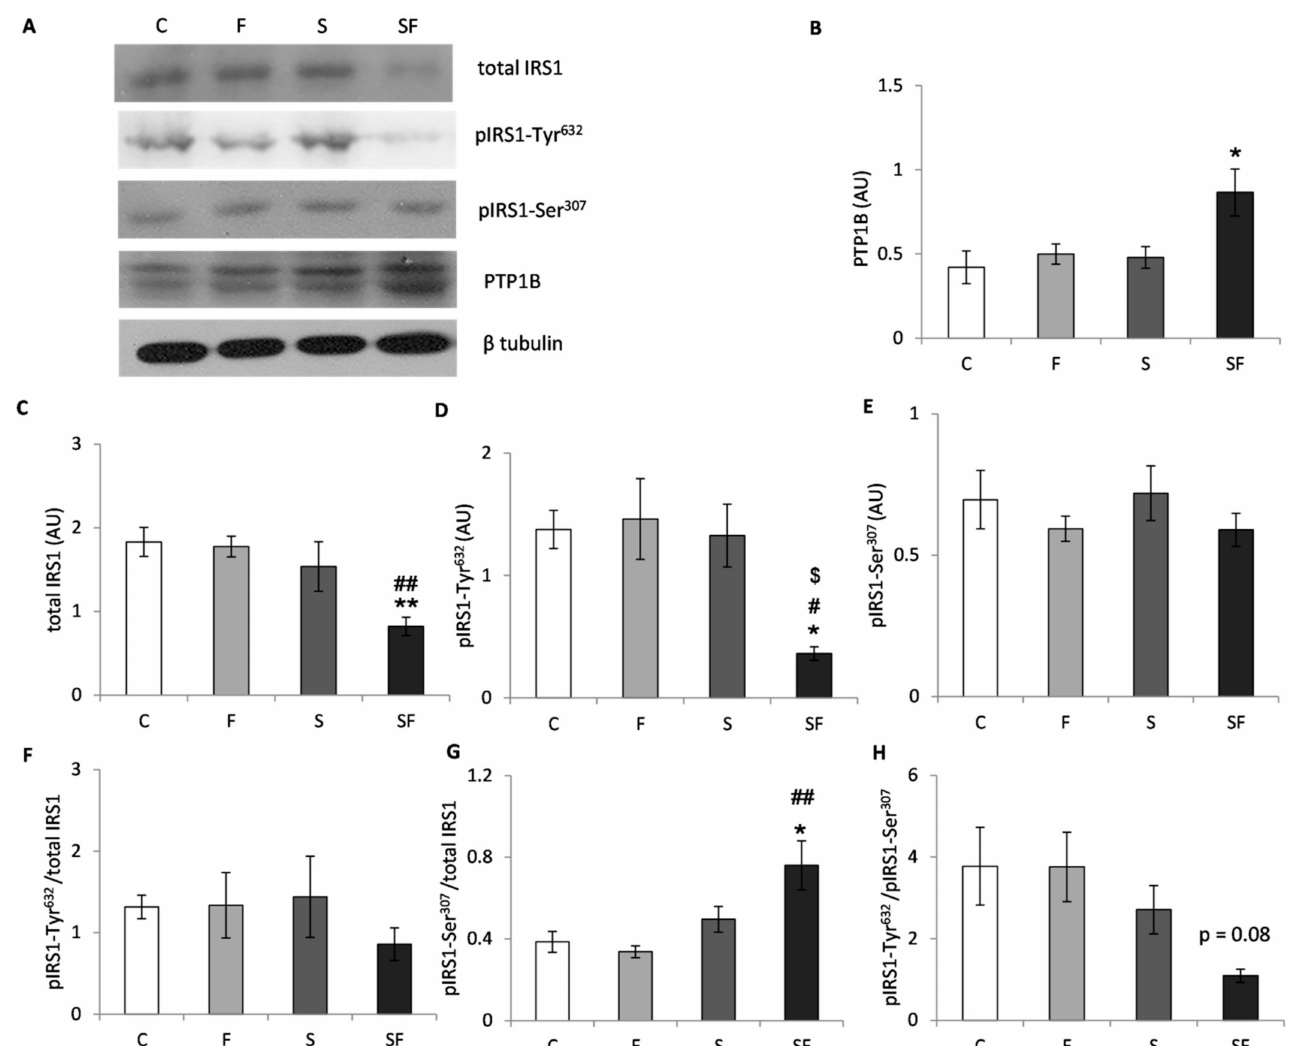
Figure 6. Protein levels of total IRS1, its activating and inhibitory phosphorylations and PTP1B in skeletal muscle of control (C), fructose (F), stress (S), and stress + fructose (SF). Representative Western blots ( A ) of protein levels of total IRS1 ( C ), pIRS1-Tyr632 ( D ), pIRS1-Ser307 ( E ) and PTP1B ( B ) in the muscle tissue extracts. The values represent the mean ± SEM (n=8-9 animals per group) for each protein normalized to β tubulin expressed in arbitrary units (AU) as well as for the ratio of phosphorylated and total protein ( F , G ) and ratio of activating and inhibiting phosphorylation ( H ). Significant between-group differences from post hoc Tukey test are given as follows: * p < 0.05 and ** p < 0.01, SF vs. C; # p < 0.05 and ## p < 0.01, SF vs. F; $ p < 0.05, SF vs. S. IRS1—insulin receptor substrate 1; PTP1B—protein tyrosine phosphatase